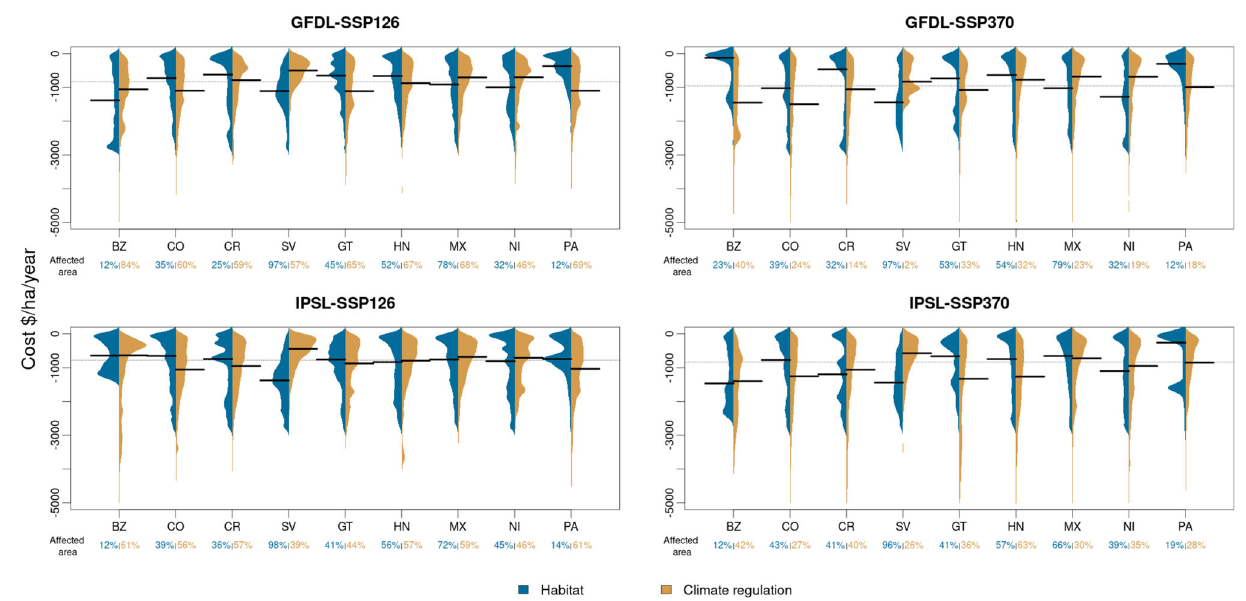
Fig.3|Country-leveldistributionofecosystemservicelosses(globalprices,no discounting). Beanplotsshowingthedistributionandmedian(boldblacklines)of economic costs for declining habitat services (blue color) and decreased climate regulation (dark yellow), separated by country (BZ Belize, CO Colombia, CR Costa Rica, SV El Salvador, GT Guatemala, HN Honduras, MX Mexico, NI Nicaragua, PA